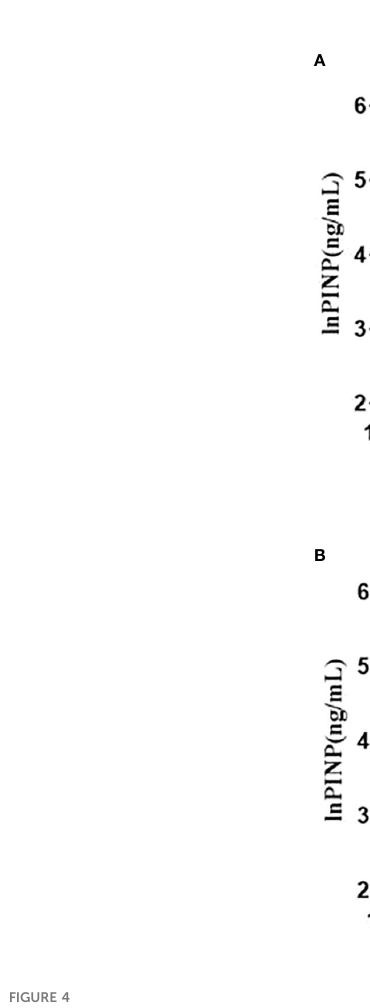
FIGURE 4 The relationship between serum sodium and lnPINP in patients with T2D (A) unadjusted; (B) partially adjusted for age, sex, BMI and